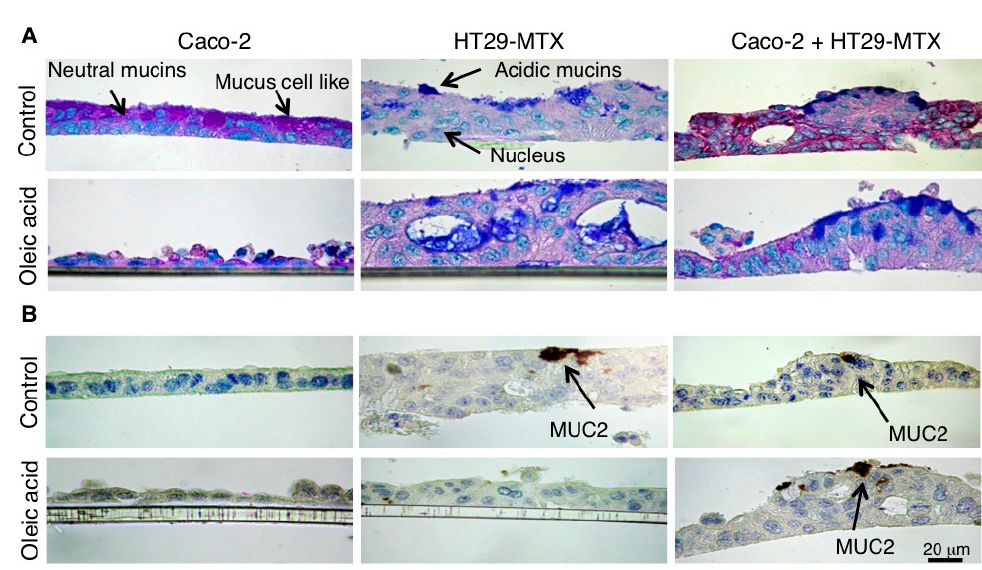
Figure 4. Morphological changes induced in Caco-2 and HT29-MTX cells in co-cultures and the effects of oleic acid. Caco-2 and HT29-MTX cells were cultured separately or mixed (9/1) until full differentiation (Day 18) on 12-well insert plates and treated for 4 h with either vehicle (Control) or oleic acid complexed to bovine serum albumin (20 μ M) then fixed with Carnoy’s reagent for detection of ( A ) Periodic acid Schiff (PAS) and Alcian blue (AB) staining, acidic mucin (blue) and neutral and sialylied mucins (pink magenta) and ( B ) mucin 2 (MUC2) immuno-histochemical detection (Brown-black), with FastRed/naphtol detection of phosphatase alcalin (PA) activity (red) and Mayer hematoxilin labeling of tissue.